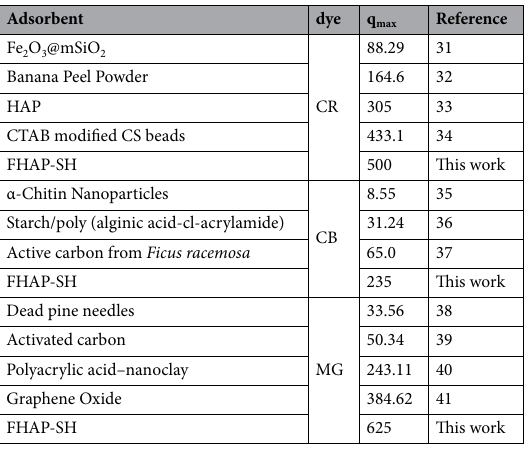
Table 2. Adsorption capacity of CR, CB, and MG as compared to other adsorbents.